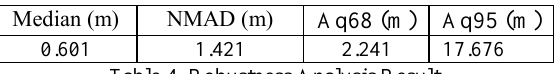
Table 4. Robustness Analysis